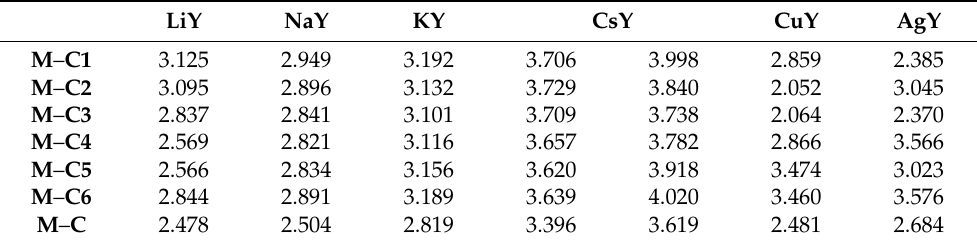
Table 1. Distance between the aromatic ring of toluene and sorbents upon adsorption. C corresponds to the aromatic center of toluene; M = Li, Na, K, Cs1, Cs2, Cu, and Ag. LiY NaY KY CsY CuY AgY 3.125